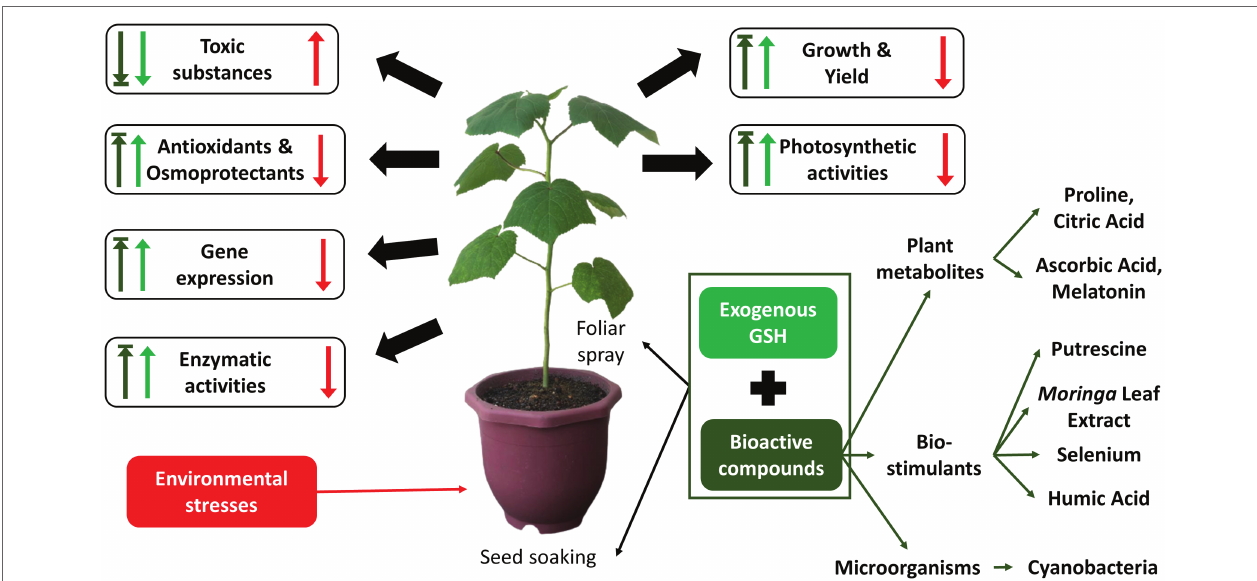
FIGURE 5 | Summarized key effects of combined application of exogenous GSH and different bioactive compounds on plants in response to environmental stresses studied in year 2018–2021. Red arrows indicate the effects of environmental stresses in plants; light green arrows indicate effects of individual exogenous application of GSH; dark green arrows indicate effects of combined application of exogenous application of GSH and other bioactive compounds in response to the environmental